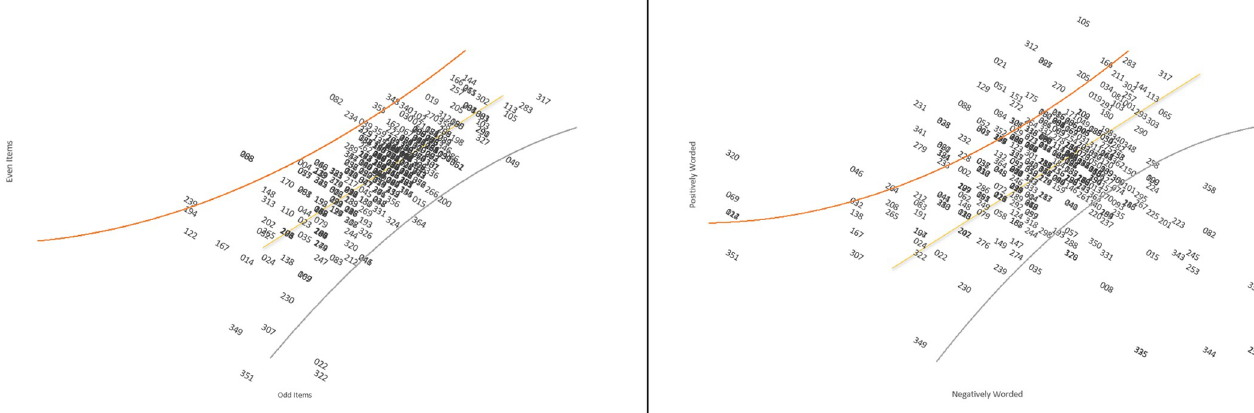
Fig 1. Scatterplot of the persons estimates after the division of the items into even and odd (left) and positively worded and negatively worded items (right). The de-identified numbers indicate the study participants. The x-axis and y-axis indicate the participants’ latent trait estimated from a different subset of items (e.g. in the picture on the left, the x-axis displays the participants’ latent trait according to their responses to odd-numbered items and the y-axis displays the participants’ latent trait according to their responses to even-numbered items). The yellow line is the identity line and the confidence bands are the 95%